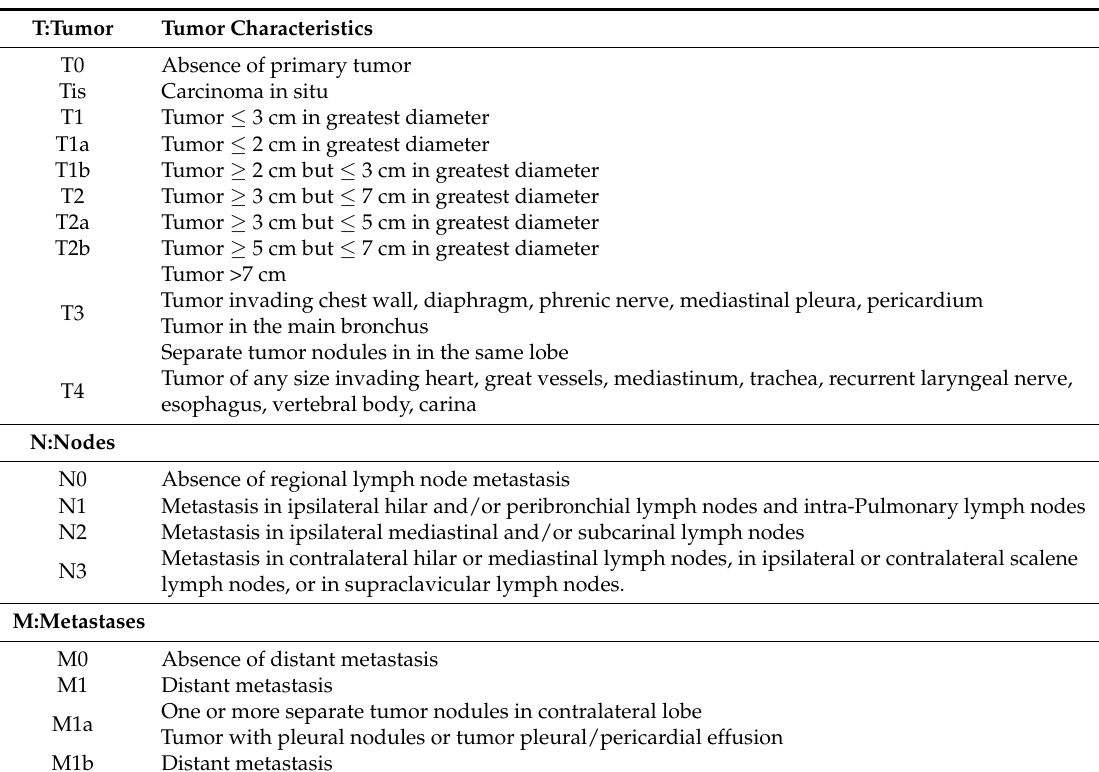
Table 2. Classification of tumor, node and metastasis of lung